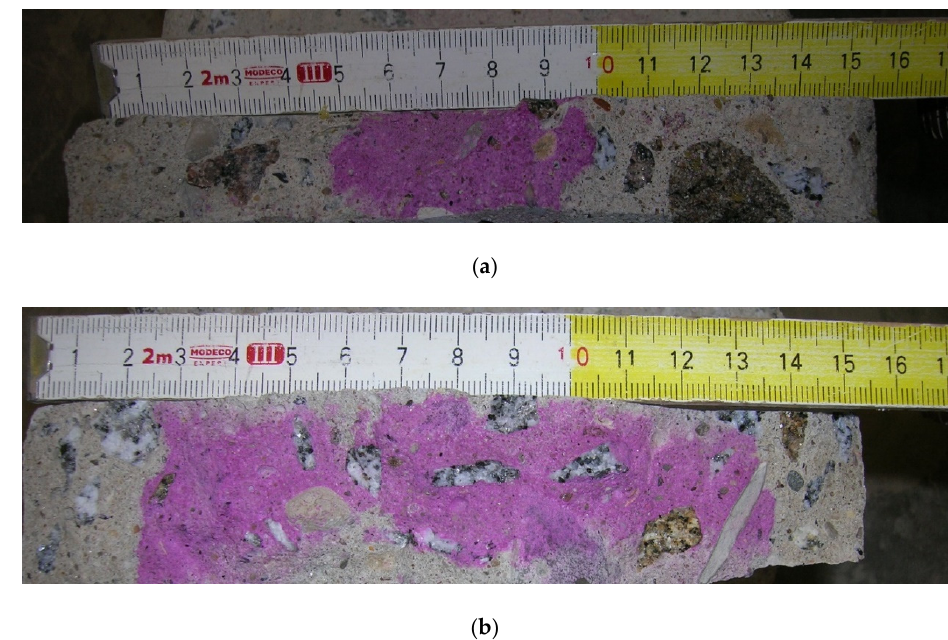
Figure 2. Depth of carbonated zone: ( a ) about 5 cm; ( b ) about 2.5 cm.